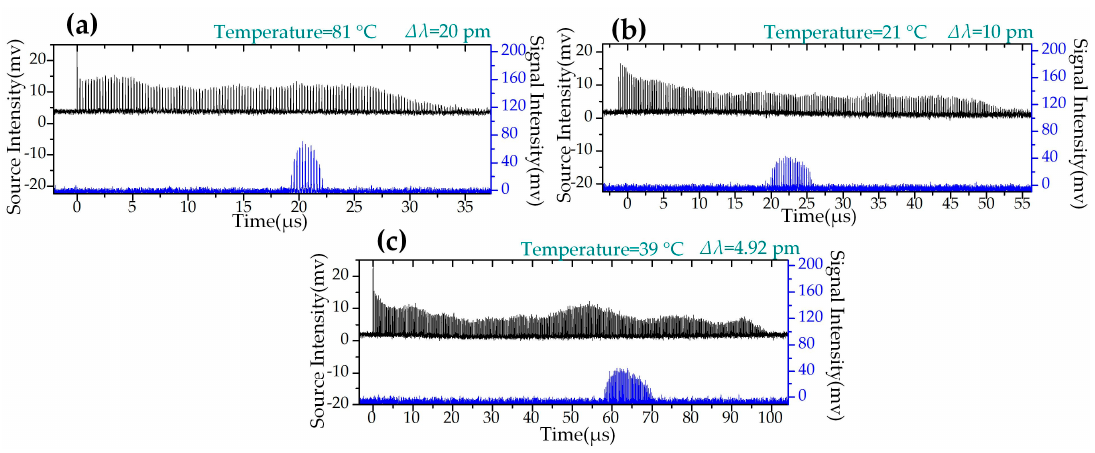
Figure 5. Waveforms of FBG temperature sensing based on WSSL with different sweep steps ( ∆λ ). ( a ) ∆λ = 20 pm and the temperature is 81 °C. ( b ) ∆λ = 10 pm and the temperature is 21 °C. ( c ) ∆λ = 4.92 pm and the temperature is 39 °C.